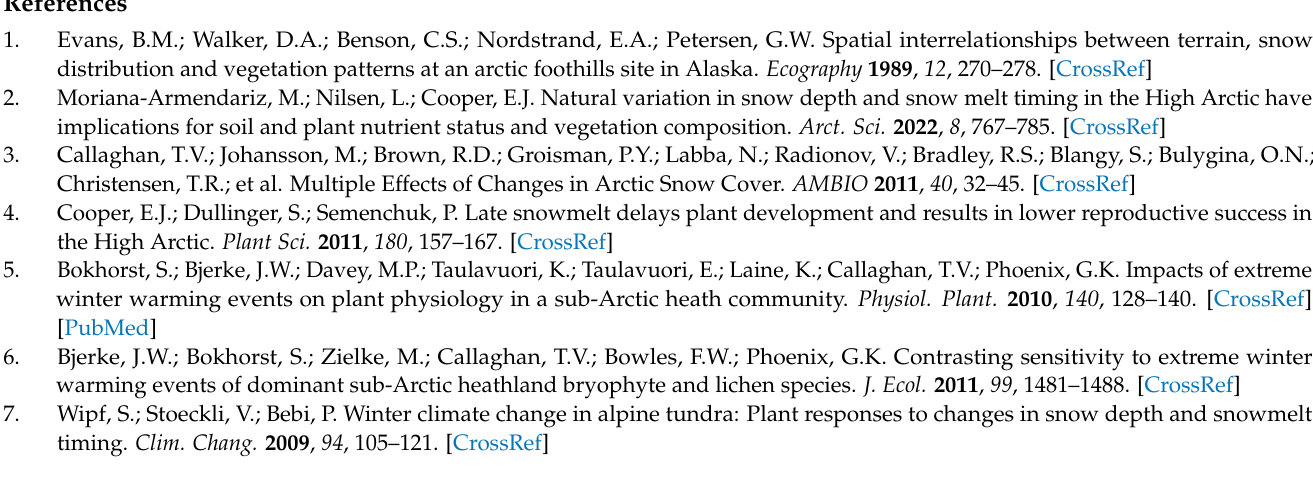
Table S7: Confusion matrix showing accuracy of Landsat 7 24 June 2018 satellite image in classifying snow-covered pixels, using 25 June 2018 Sentinel-2 image for validation; Table S8: Confusion matrix showing accuracy of Landsat 7 27 June 2019 satellite image in classifying snow-covered pixels, using 27 June 2019 Sentinel-2 image for validation; Table S9: Confusion matrix showing accuracy of Landsat 7 2 July 2021 satellite image in classifying snow-covered pixels, using 1 July 2021 Sentinel-2 image for